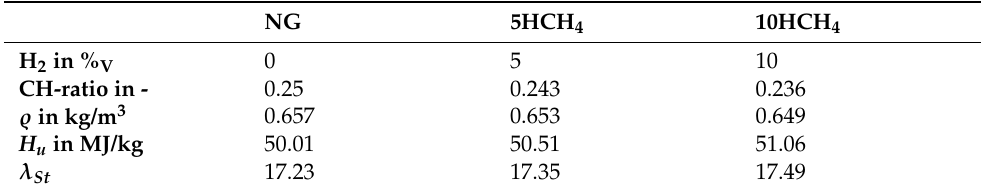
Table 4. Properties of the used